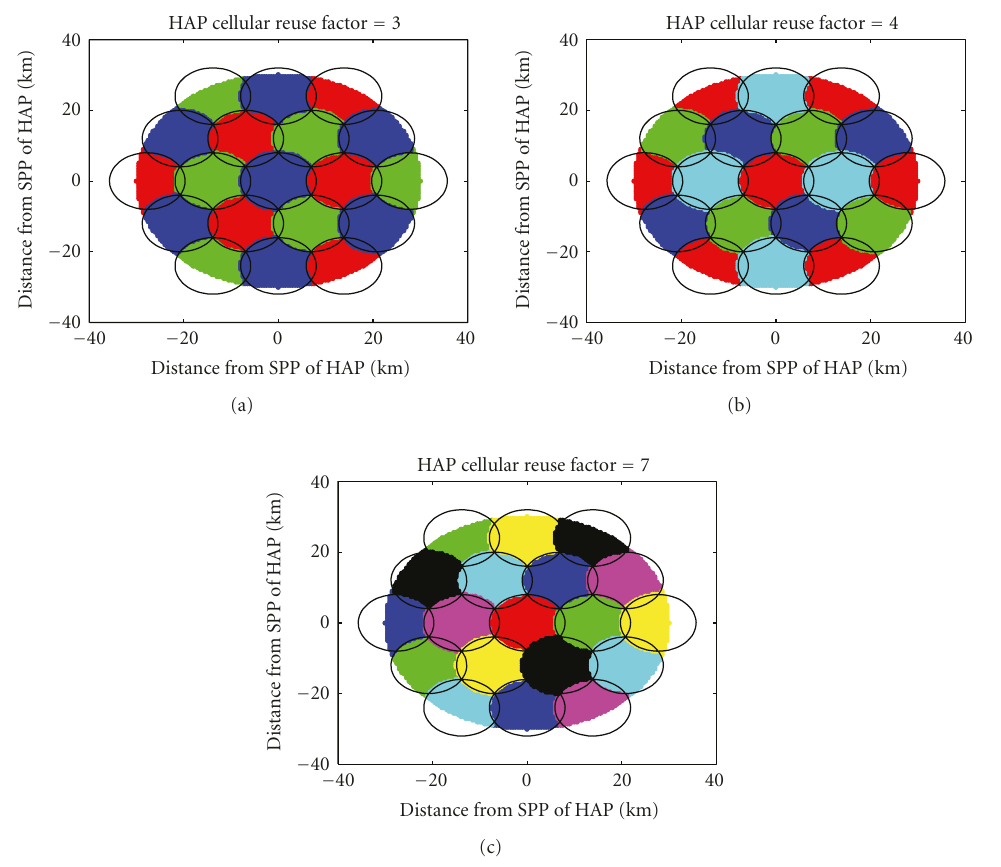
Figure 7: HAP cell layouts with the reuse factor N at 3, 4, and 7.